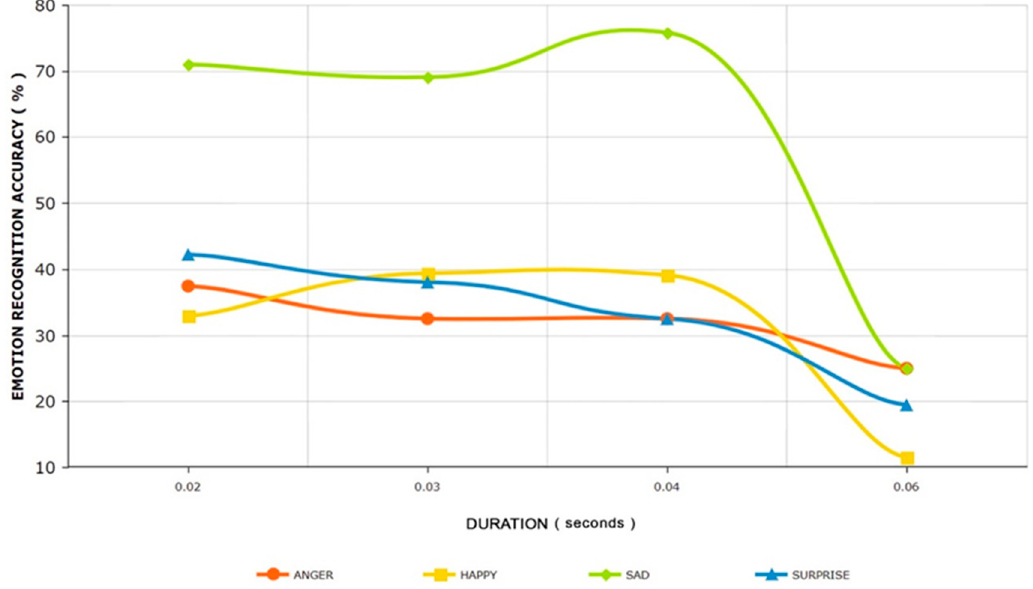
Figure 3. The overall mean for emotion perception by Asian ethnics based on speech duration.